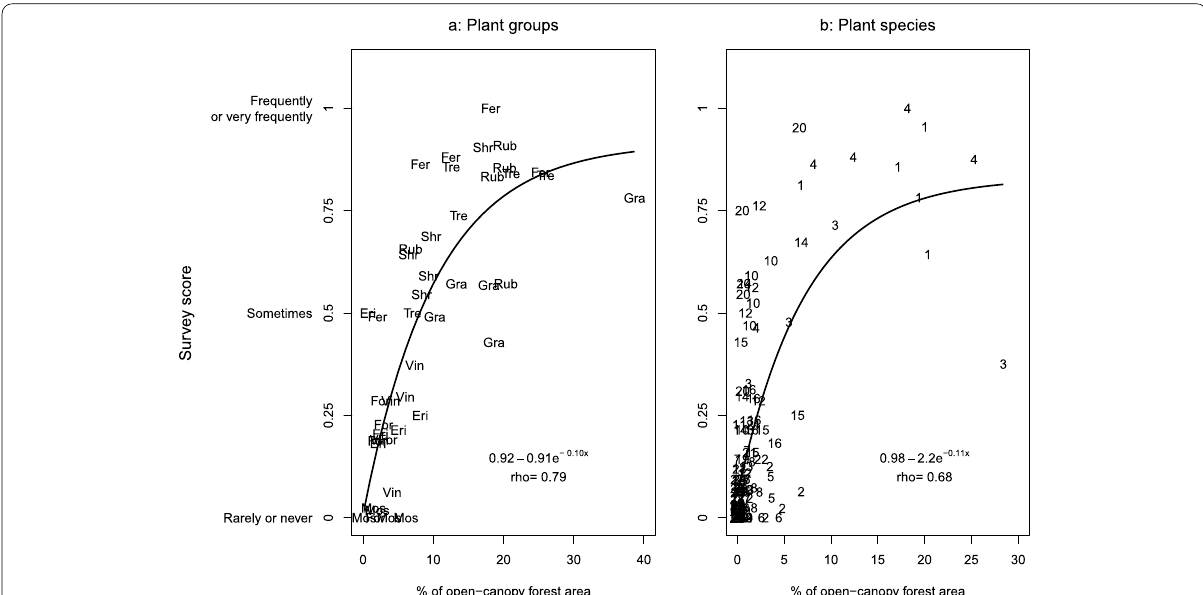
Fig. 5 Forest manager survey score as a function of % A PC > 50, CC < 50 (percentage of the forest area in open‑canopy conditions where a the plant group or b the plant species shows high cover, as defined in Table 2 in each of the five regions. Black curves correspond to the prediction of the asymptotic model according to Eq. 1. In each plot, each group or each species has five repetitions (one per region). a Names correspond to plant group names, and b numbers correspond to species number, as defined in Appendix Table 4. Please note that the y‑axis scale changes between the two